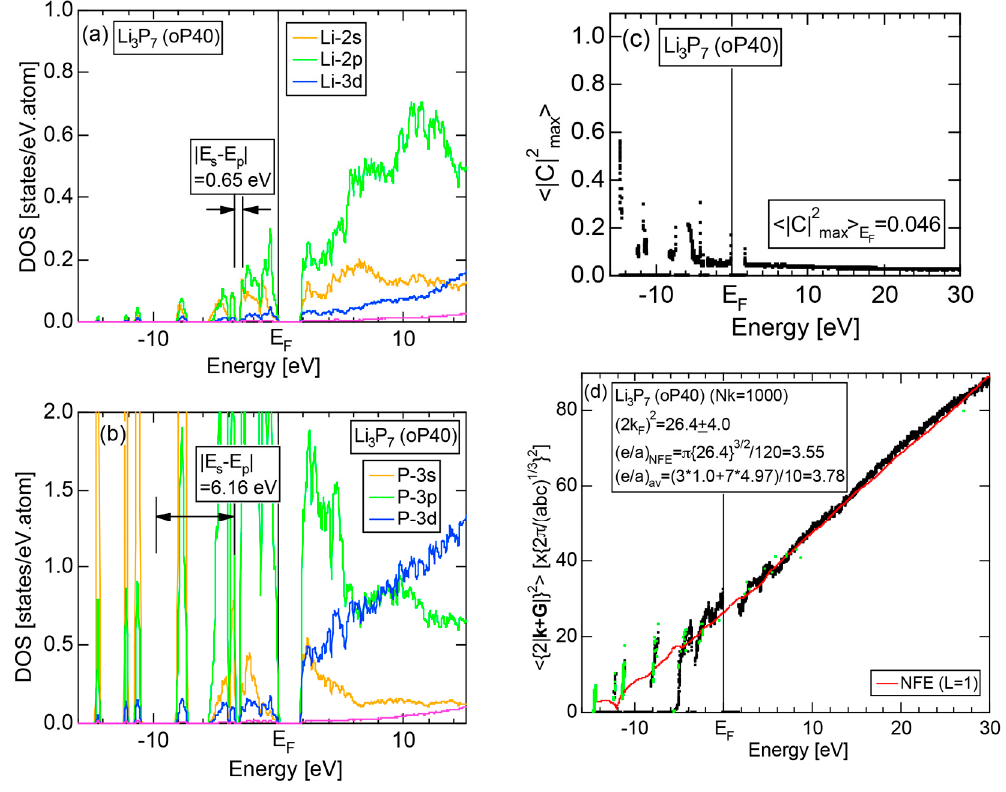
max2 (cid:69) (cid:68) and ( d ) Hume-Rothery plot for Li 3 P 7 (oP40). The | C | 2 and ( d ) Hume-Rothery plot for Li 3 P 7 (oP40) [11,12]. E max E